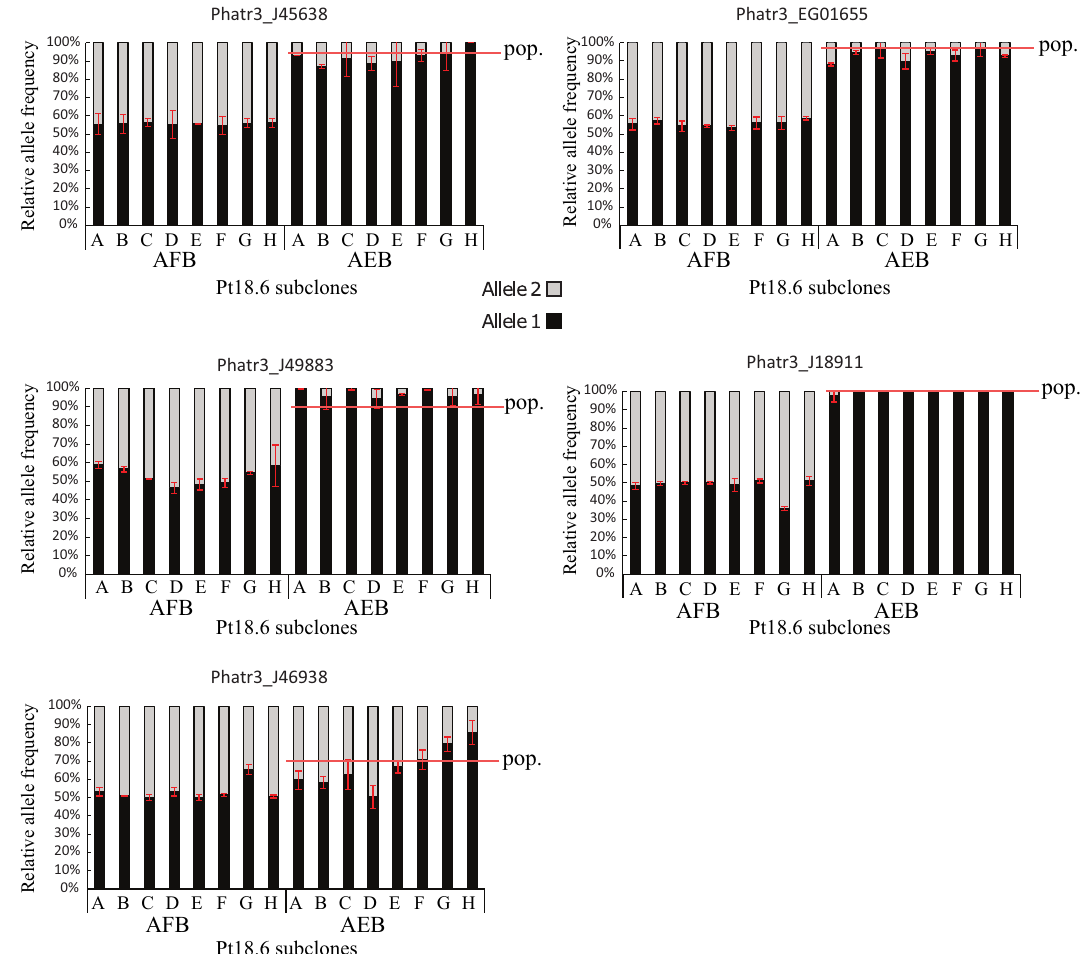
Figure 2. Allele-specific expression is stable upon clonal propagation in P. tricornutum . Pyrosequencing results for MAE genes in Pt18.6 subcloned populations (A to H). We represented allele frequency % for each SNV as given by pyrosequencing values. By default, alleles are named ‘allele 1’ and ‘allele 2’, and ‘allele 1’ is the most expressed allele. Error bars represent the standard deviation between 2 technical replicates. SNVs are the same as in table of Supplementary Dataset 1 for the corresponding genes. For each SNV we represent the observed allele frequency (extrapolated from obsAEB) at the population level (Fig. 1) in cDNA by a red line. J45638: 6-pyruvoyl tetrahydropterin synthase; EG01655: unknown function; J49883: glycosyltransferase; J18911: aminoacyl-tRNA synthetase; J46938: NnrU domain containing